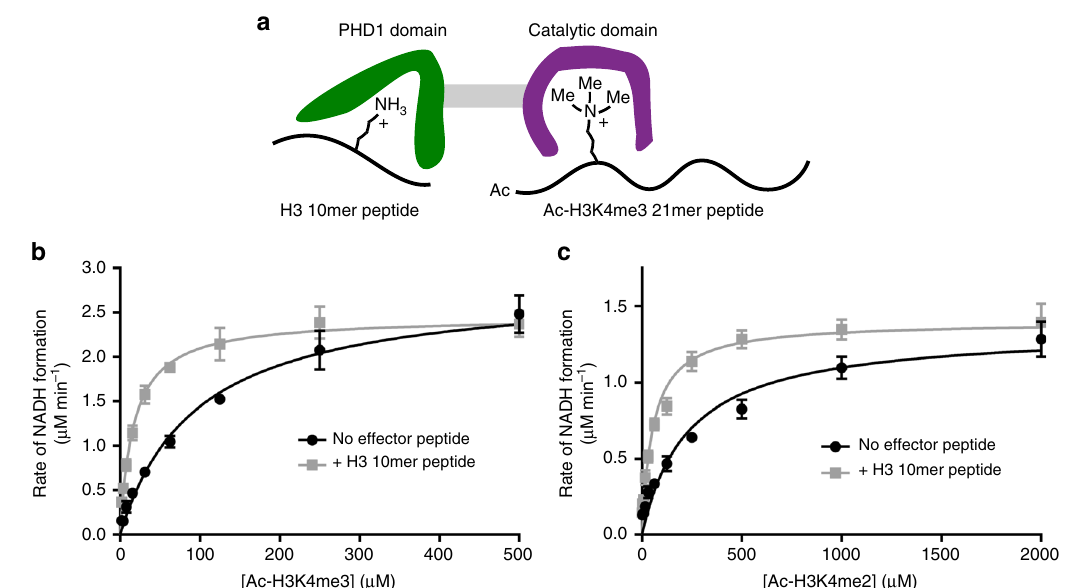
Fig. 2 The catalytic ef fi ciency of KDM5A is enhanced upon ligand binding to PHD1. a Schematic representation of the discrete occupancy activity assay in which an N-terminally acetylated 21mer peptide substrate (H3 A1-A21) and a 10-mer PHD1 ligand peptide (H3 A1-S10) are used. b Michaelis – Menten plot of KDM5A-catalyzed demethylation of Ac-H3K4me3 21mer peptide in the presence and absence of a saturating concentration (38 µ M) of unmodi fi ed H3 10mer effector peptide. c Kinetic parameters of demethylation of the Ac-H3K4me2 21mer substrate as a function of the presence of the effector peptide. Both ( b ) and ( c ) are fi tted to the Michaelis – Menten equation. Kinetic parameters are shown in Table 2. Errors ( n ≥ 3) represent s.e.m.